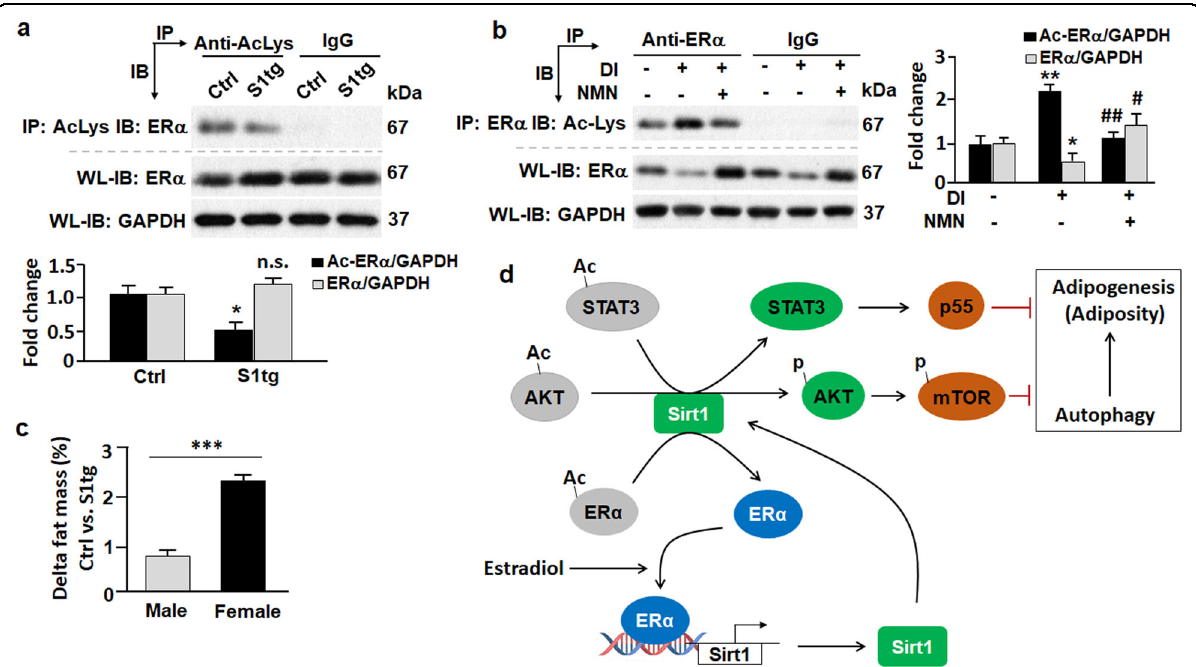
Fig. 6 Sirt1-induced deacetylation of ER α and reduction of adiposity in mice. a Effects of Sirt1 overexpression on ER α acetylation in mice. Upper, acetylated ER α was analyzed by immunoprecipitation (IP) with an anti-acetylated lysine (anti-acLys) antibody that pulled down acetylated proteins, followed by immunoblot (IB) with an anti-ER α antibody. Normal rabbit IgG (non-speci fi c IgG) was used as negative control. Middle, whole lysates (WL) were analyzed by IB with anti-ER α and anti-GAPDH antibodies. Lower, densitometric analyses were used to quantify acetylated and total ER α in control (Ctrl) and Sirt1 transgenic (S1tg) mice. * p < 0.05; n = 8. b Effects of Sirt1 activator nicotinamide mononucleotide (NMN, 100 µM) on ER α acetylation in 3T3L1 cells. Left-upper, acetylated ER α was analyzed by IP with an anti-ER α antibody that pulled down ER α protein, followed by IB with an anti-acetylated lysine (anti-acLys) antibody. Normal rabbit IgG (non-speci fi c IgG) was used as the negative control. Left-lower, whole lysates (WL) were analyzed by IB with anti-ER α and anti-GAPDH antibodies. Right, densitometric analyses were used to quantify acetylated and total ER α in 3T3L1 cells. DI, differentiation inducer. * p < 0.05 and ** p < 0.01 by comparing DI( − ) NMN( − ) with DI( + ) NMN( − ). # p < 0.05 and ## p < 0.01 by comparing DI( + ) NMN( − ) with DI( + ) NMN( + ). n = 8. c Sirt1-induced reduction of adiposity was greater in female than in male mice. *** p <